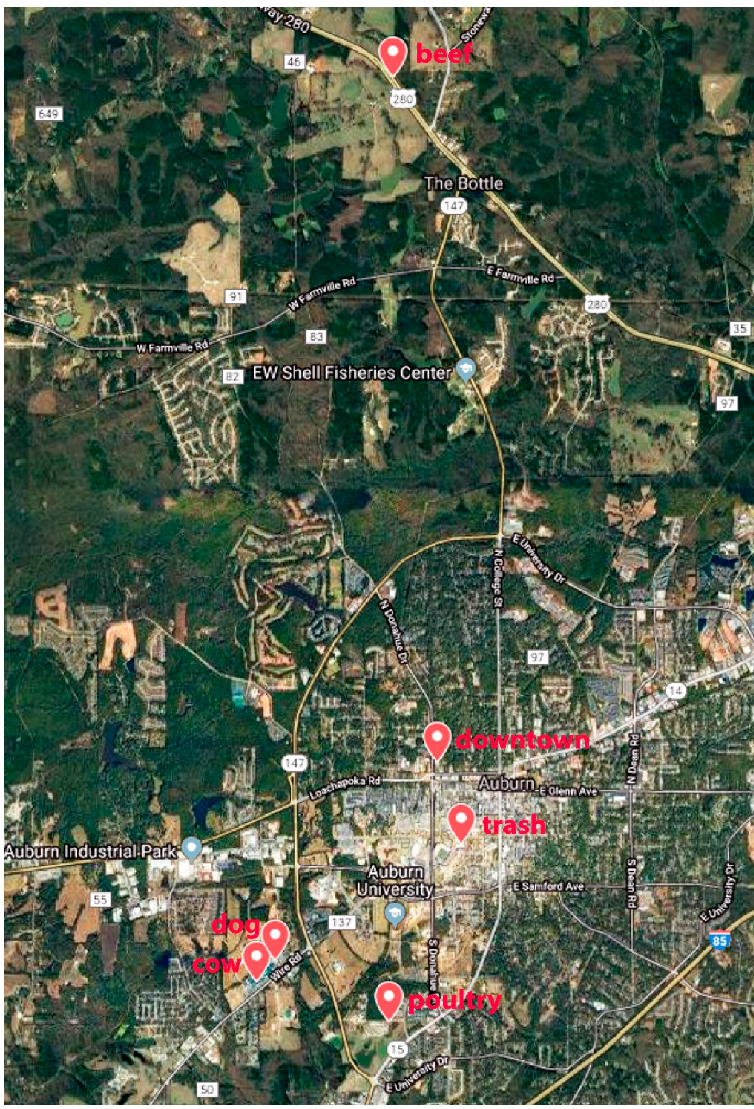
Figure 1. Locations for trapping flies in this study.